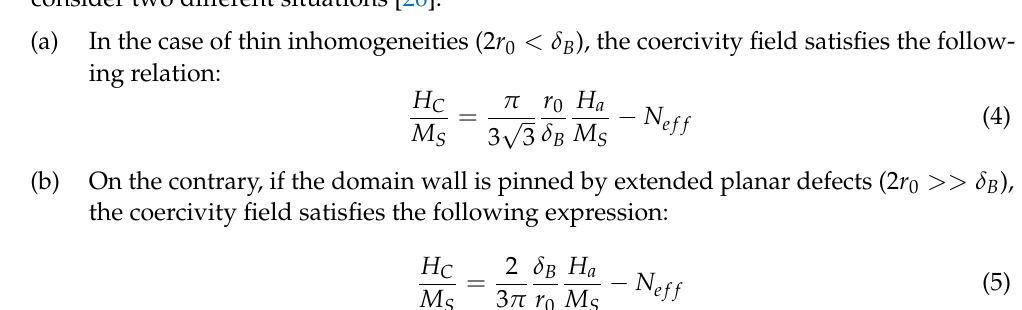
Figure 6. ( a , b ) Plots of H C / M S versus H a / M S for the S1 and S2 samples for testing the nucleation mechanism where the magnetization process is uniform; ( c , d ) the plots of H C / M S versus π H a /3 3 δ B M S for the S1 and S2 samples for testing the pinning mechanism where the pinning centers are thin inhomogeneities; ( d – f ) the plots of H C / M S versus 2 H a δ B /3 π M S for the S1 and S2 samples to test the pinning mechanism in which the pinning centers are extended planar faults.